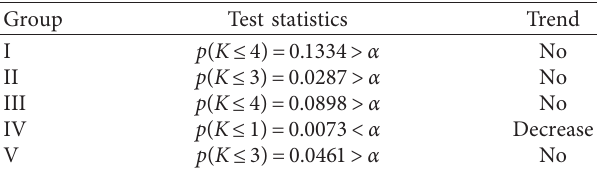
Table 5: Cox–Stuart trend test ( α � 0.01). Group